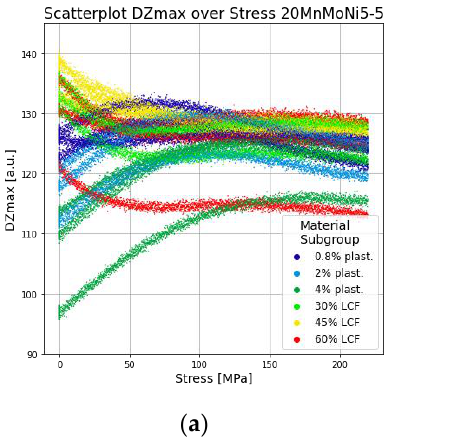
Table 4. Results of Preliminary LCF-tests.